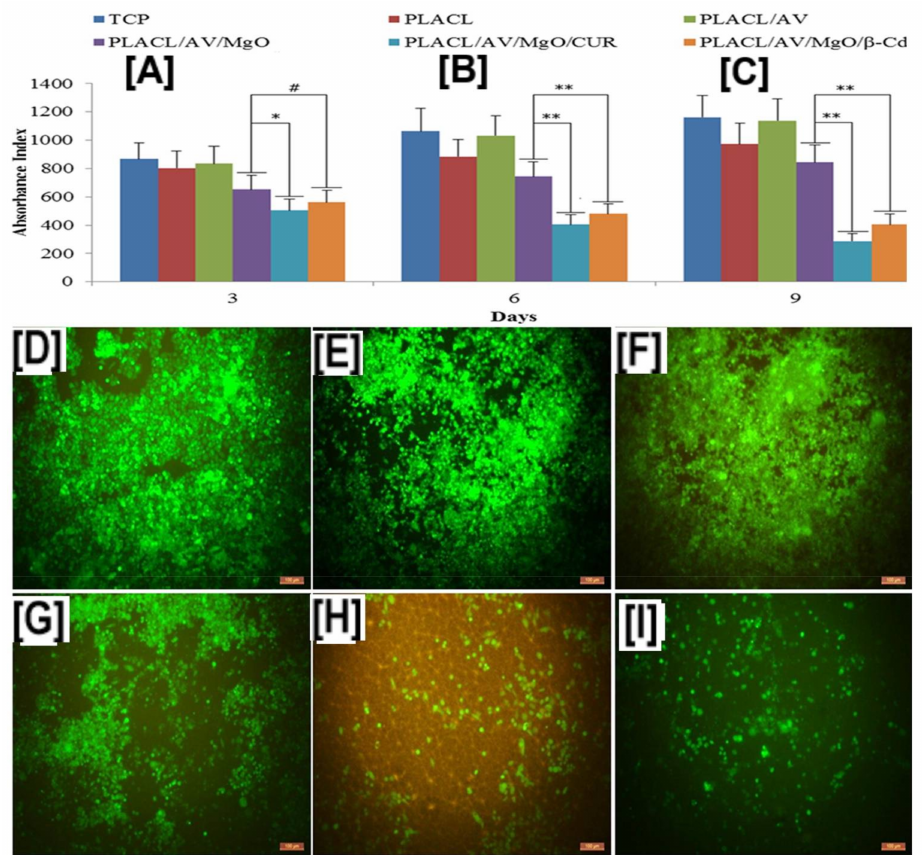
Figure 11. Proliferation and cell densities of Michigan Cancer Foundation-7 (MCF-7) cells on poly(lactide- co -caprolactone) (PLCL or PLACL) scaffolds and PLCL scaffolds containing aloe vera (AV), magnesium oxide (MgO), and free curcumin (CUR), or encapsulated in β -CD. The addition of AV alone did not cause MCF-7 cell death at all studied time points; however, the addition of CUR, in either free or encapsulated form, resulted in significant cell death of the proliferating MCF-7 cells ( A ). These results were further corroborated by laser confocal scanning microscopy measurements, which showed low cell densities in scaffolds containing CUR and MgO/CUR (11 B: ( E , F )). Images adapted and reproduced with permission from [109]. Copyright Elsevier Ltd.,